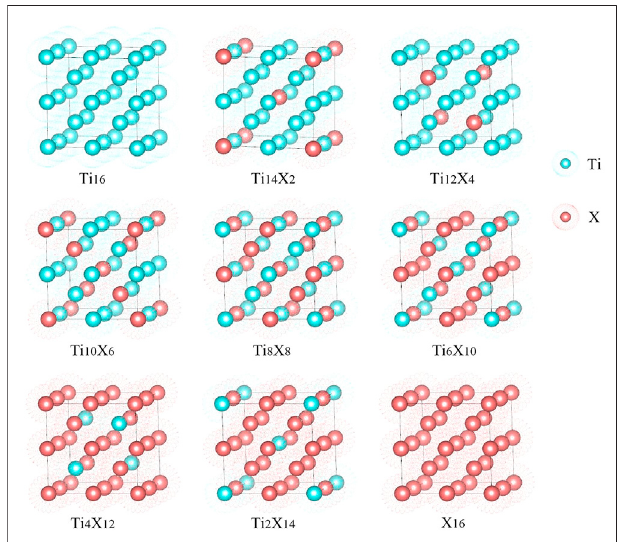
FIGURE 1 | Models of β -Ti X ( X = Nb, Ta)